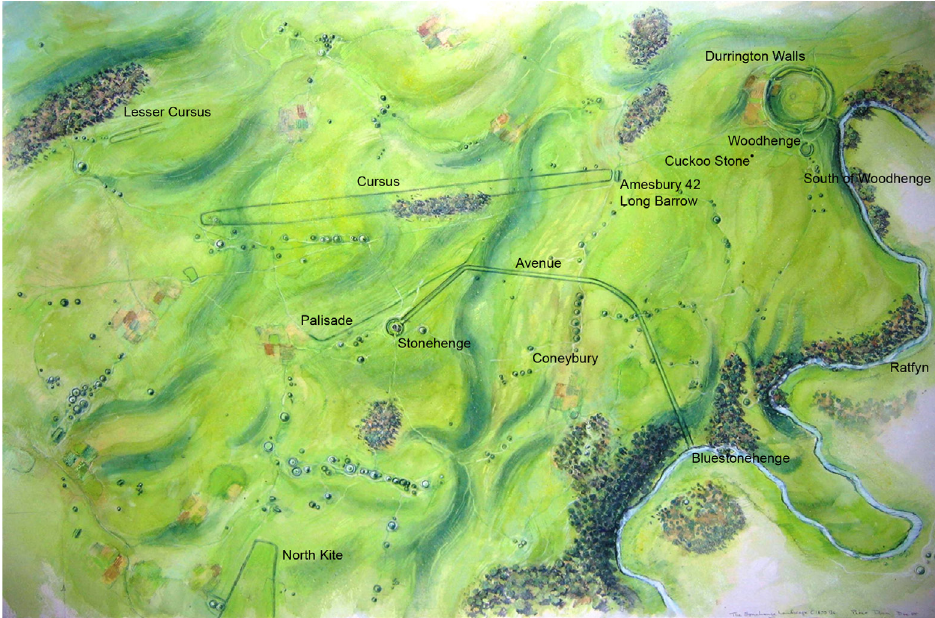
Fig. 4: The Stonehenge landscape, showing prehistoric sites and topographic features in the environs of Stonehenge (drawing: Peter